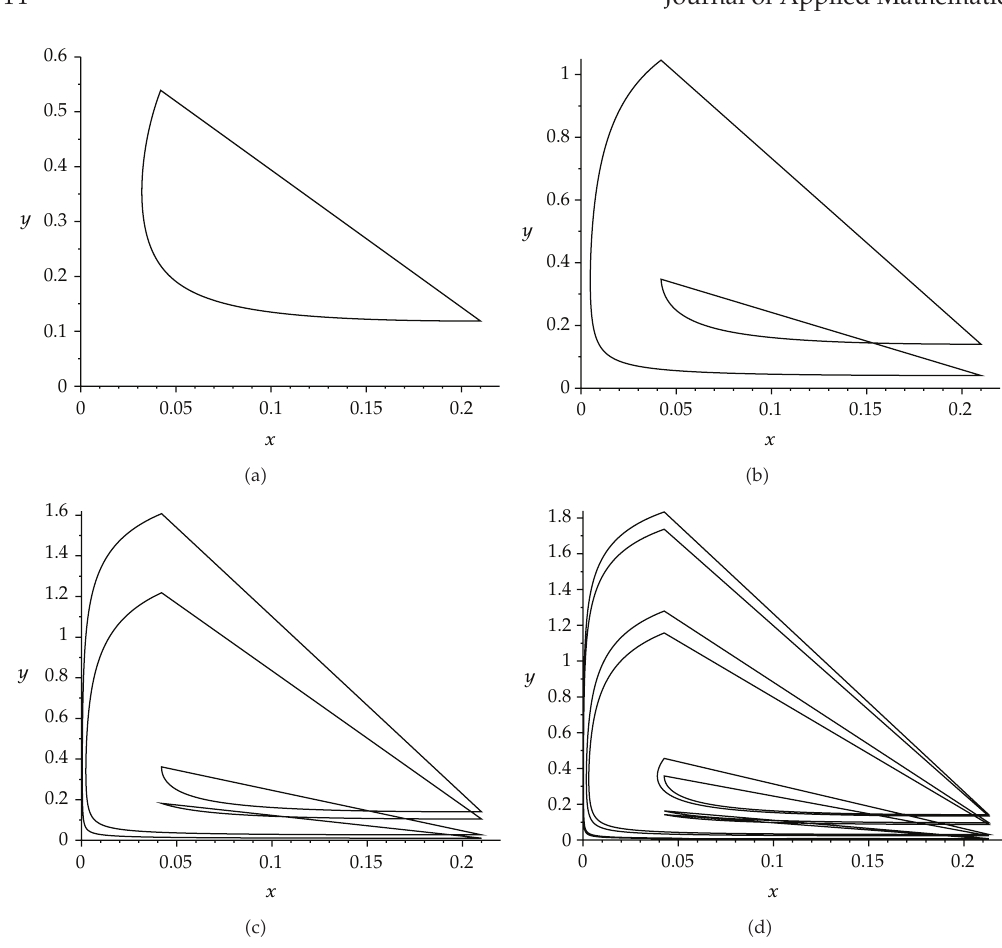
Figure 4: Periodic solutions of system (cid:7) 1.1 (cid:8) : h (cid:6) 0.21, p (cid:6) 0.8, τ (cid:6) 0 . 065; (cid:7) a (cid:8) q (cid:6) 3, (cid:7) b (cid:8) q (cid:6) 6, (cid:7) c (cid:8) q (cid:6) 10, (cid:7) d (cid:8) q (cid:6) 11 .